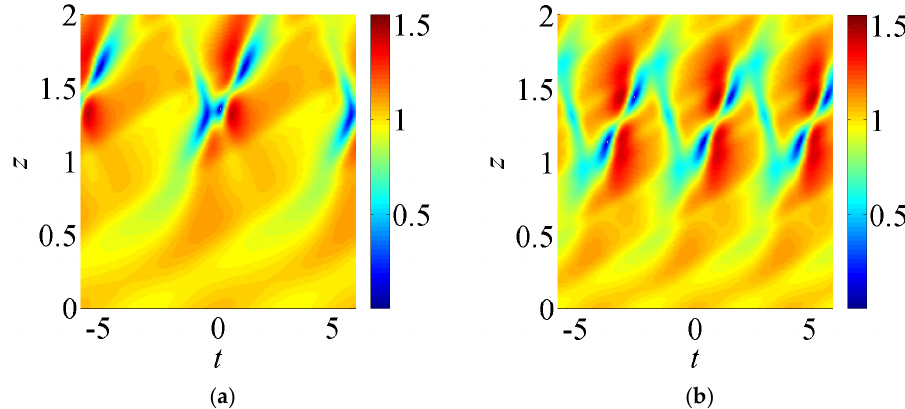
Figure 4. The u -component of the asymmetric breathers generated by simulation with the initial condition given by Equation (6) at ( a ) K = 1; ( b ) K = 1.5. In both cases, σ = 10, ρ = 1 and δ = 5.